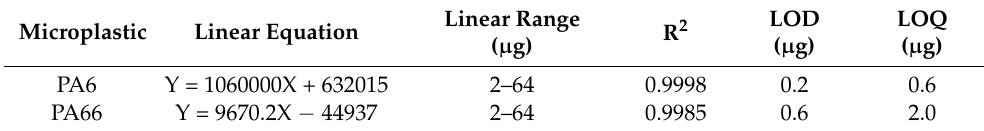
Table 3. Quantitative parameters for PA6 and PA66.